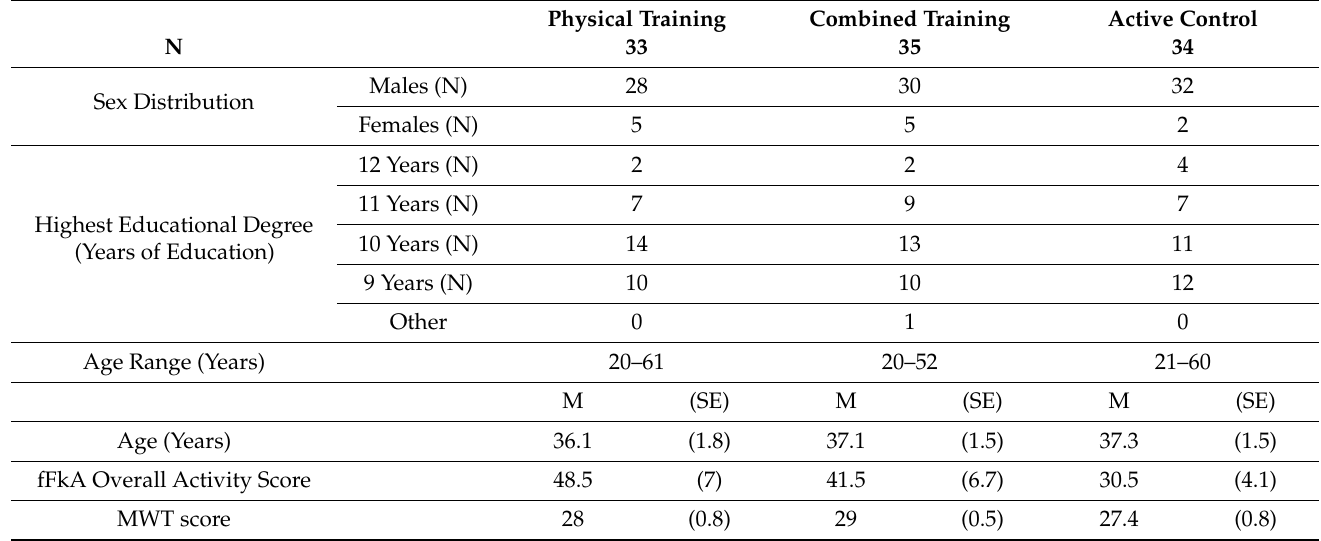
Table 1. Demographic characteristics, physical activity, and crystalline intelligence of the participant sample as a function of group (physical training, combined training, or active